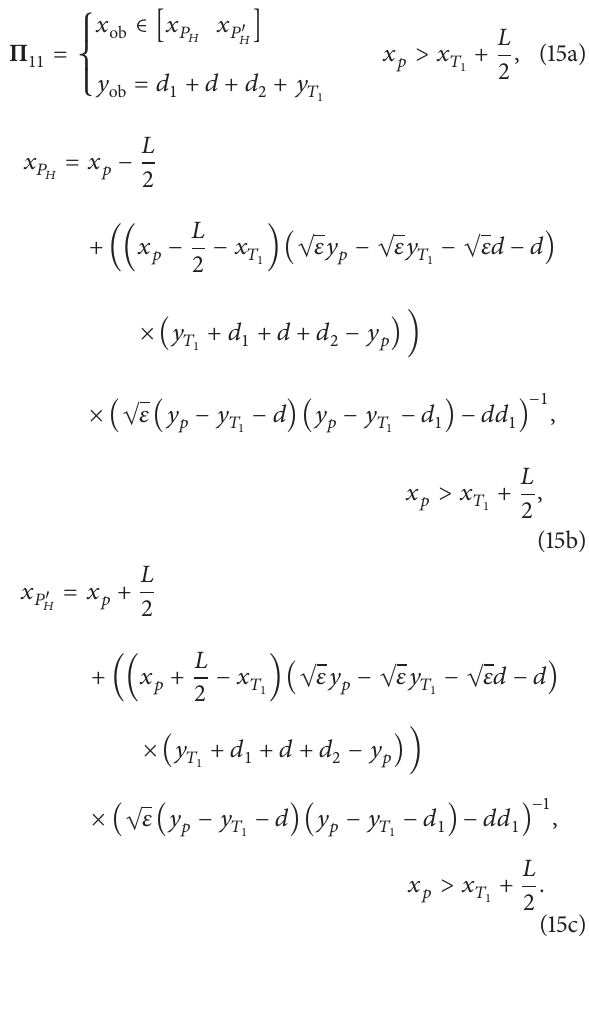
signal model, that is, (6). But the target scattering is